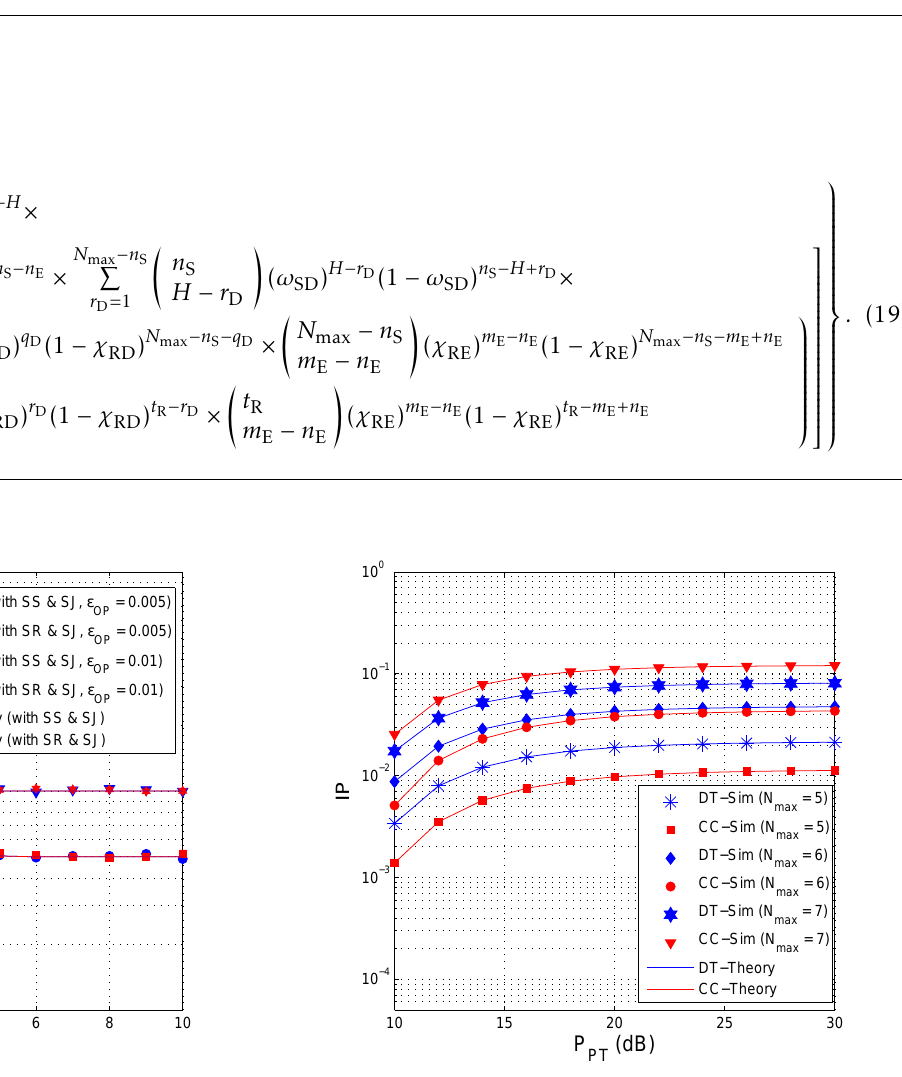
in Figure 3. IP as a function of P PT x R = 0 . 25 , y E = − 0 . 3